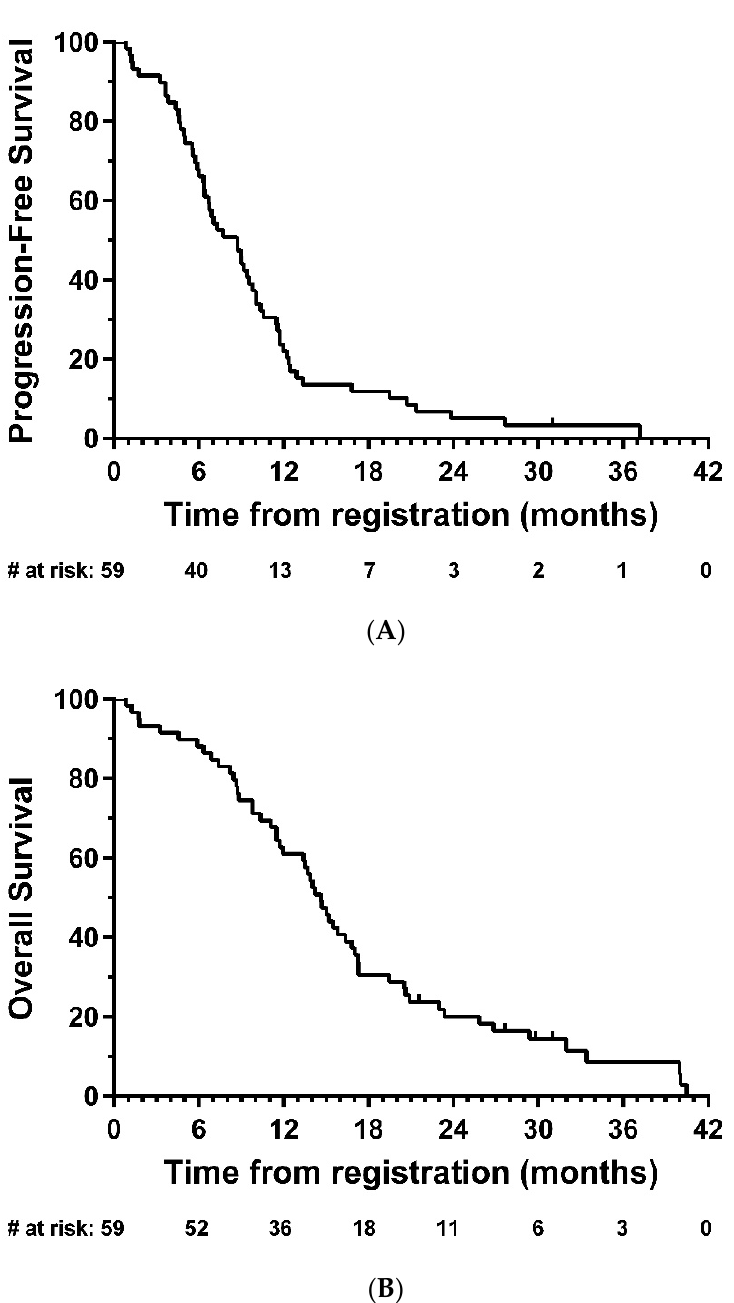
Figure 2. Kaplan–Meier plots of ( A ) progression-free and ( B ) overall survival—eligible patients. # =